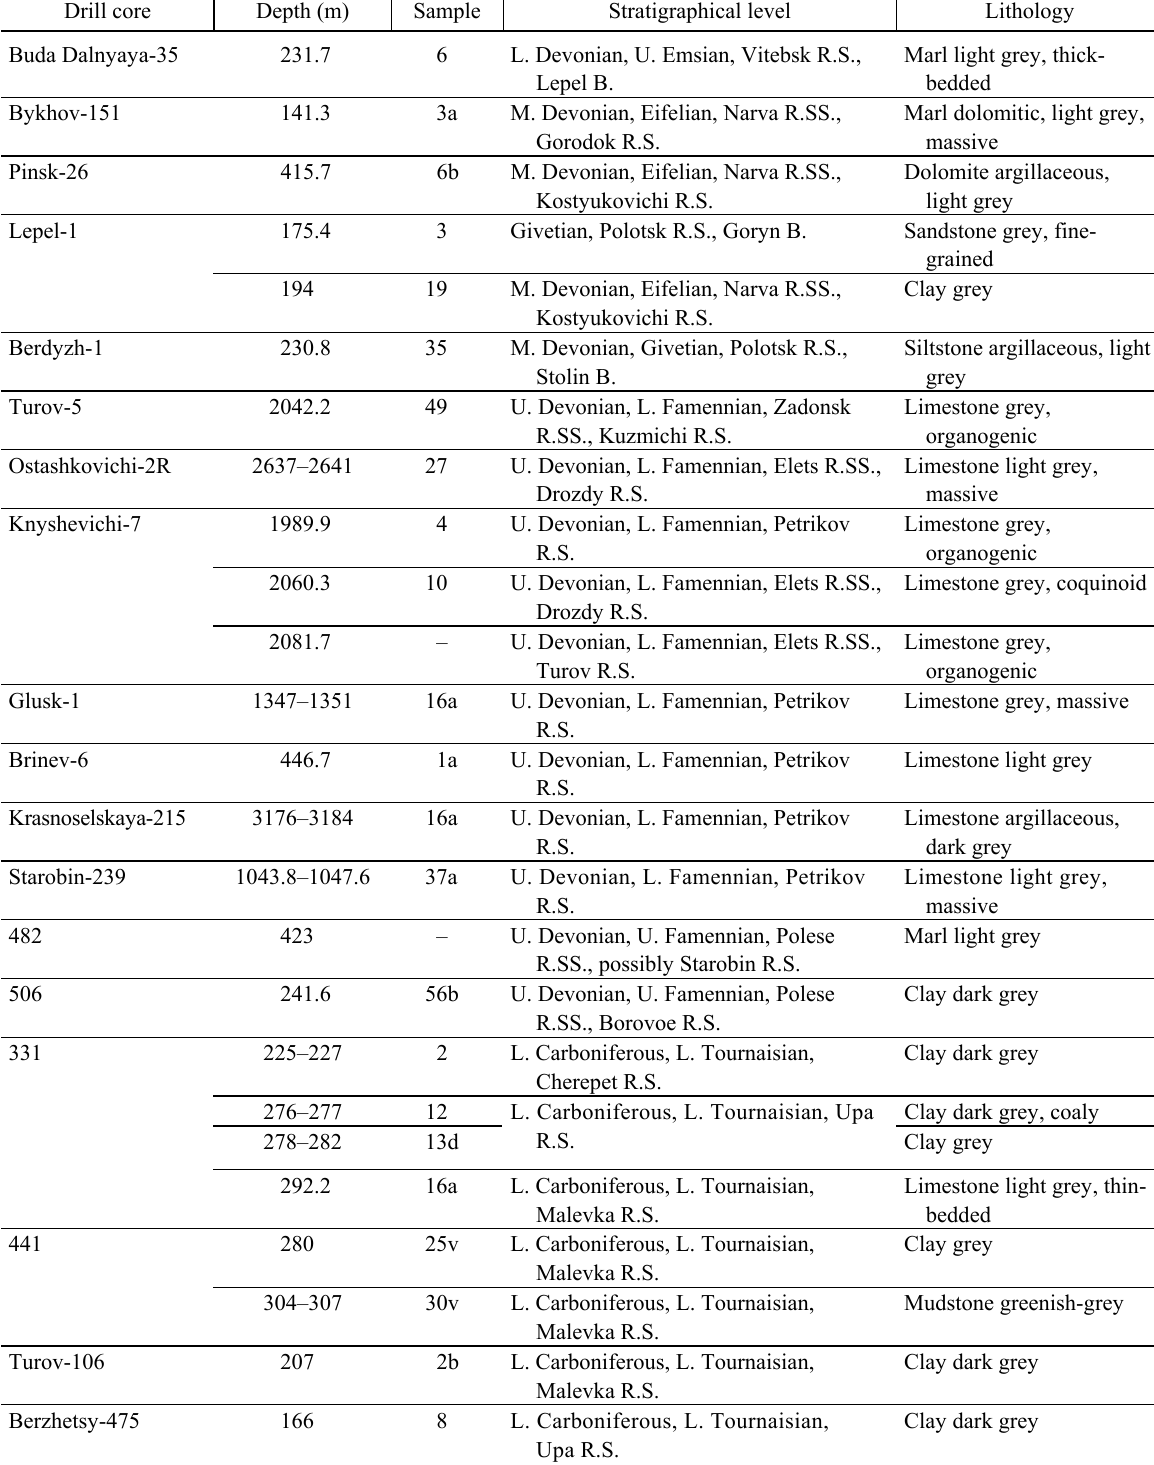
Table 1. List of drill cores and samples containing the described chondrichthyan remains Drill